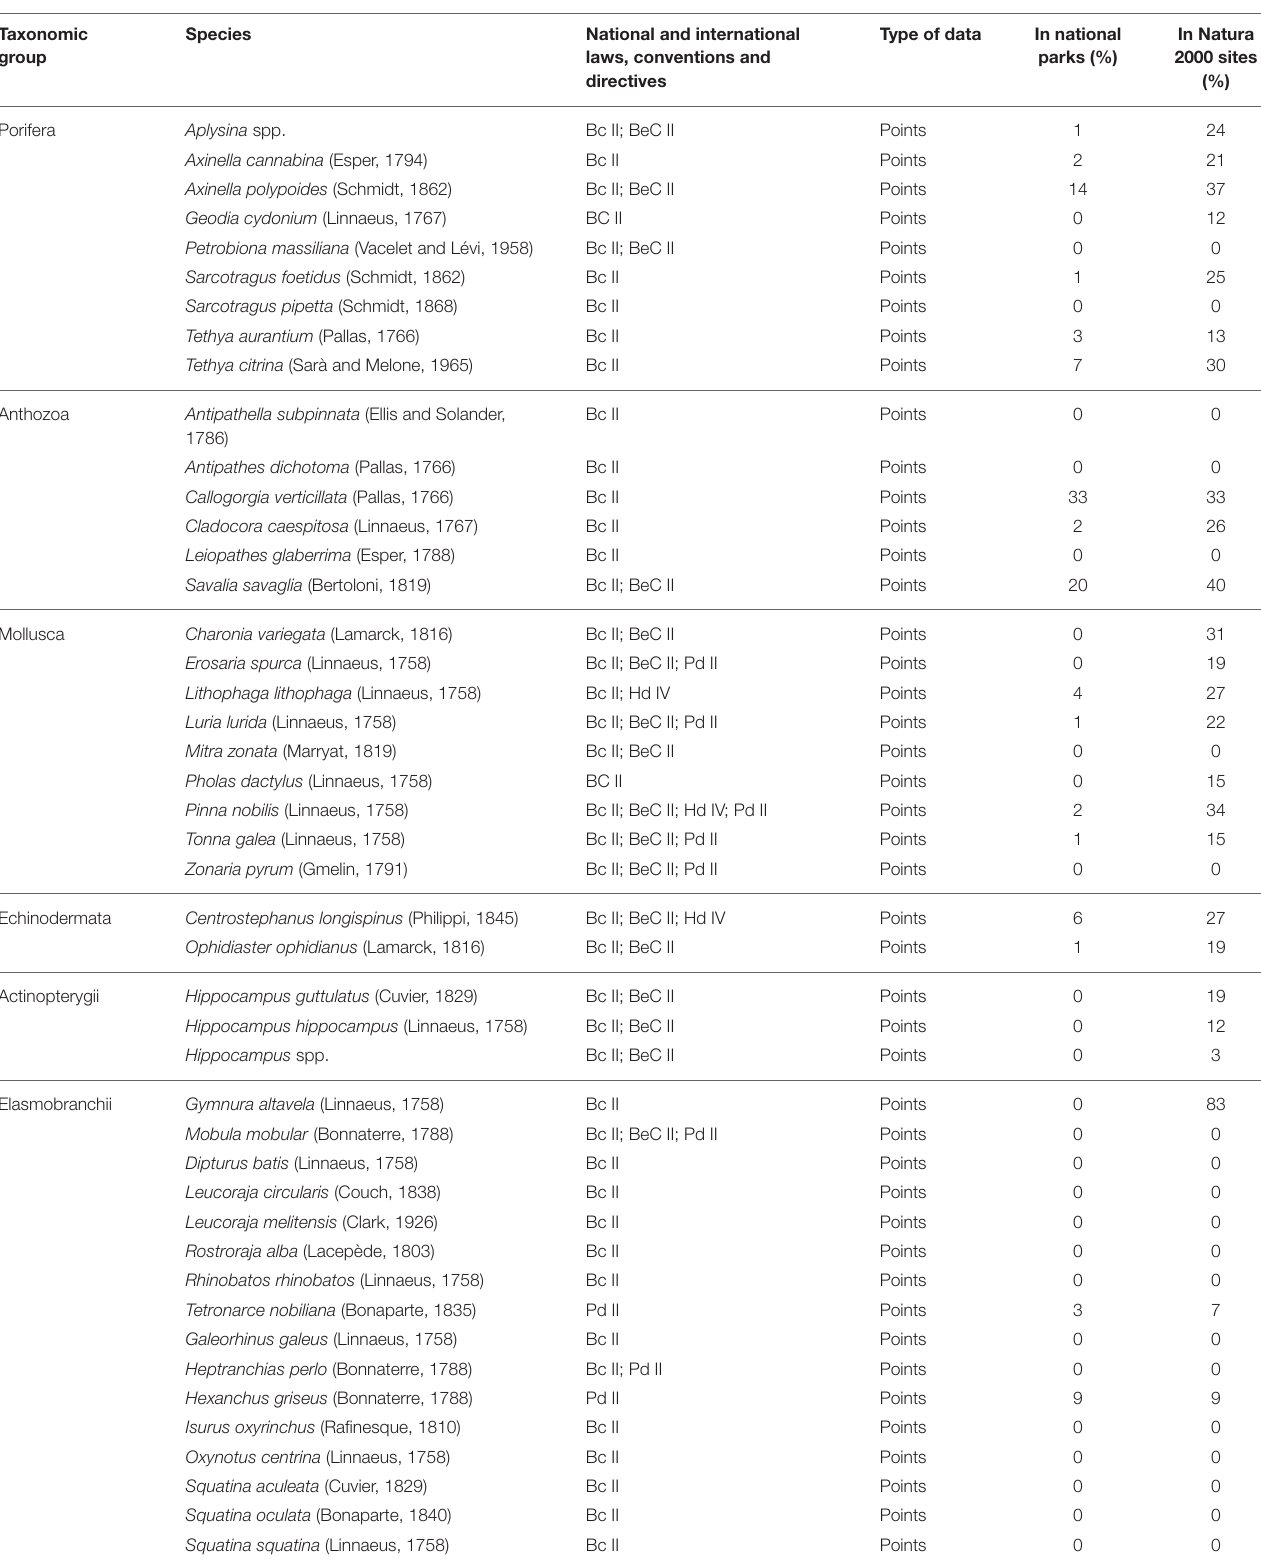
TABLE 1 | List of marine species whose distribution was investigated in the present study, and the corresponding protection status according to the Annexes of international conventions and directives. Taxonomic group